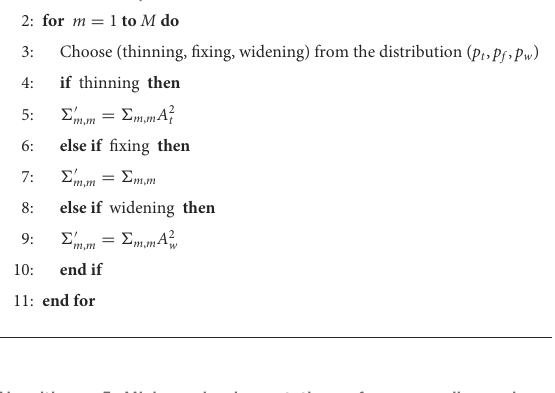
Algorithm 5 Mixing implementation for non-diagonal covariance